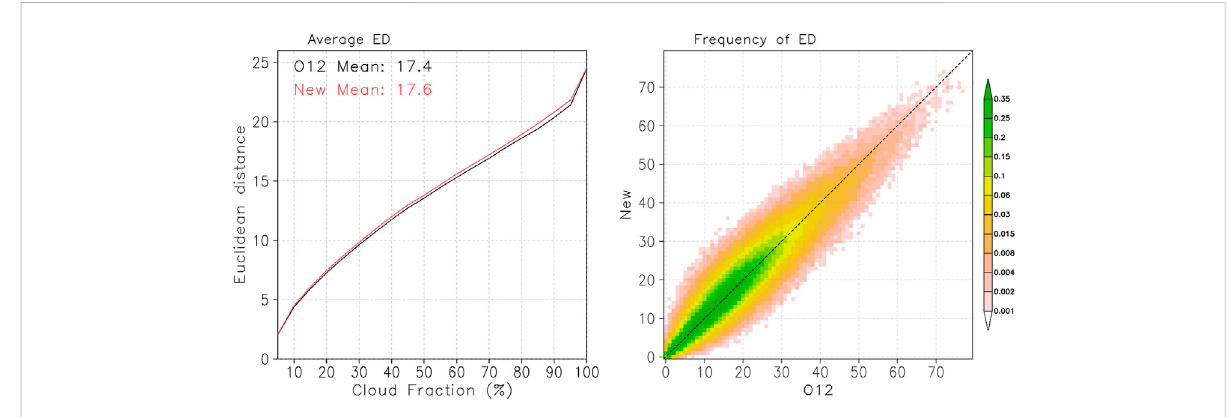
FIGURE 10 Comparison of the performance of the O12 and the present decorrelation length parameterization at the scene level. Average Euclidean Distance (ED) as a function of scene CF (binned in 5% intervals, (left panel) ; occurrence frequency of pairs of ED values obtained from the O12 and current parameterization of decorrelation lengths (binned in 1% intervals, (right panel) .